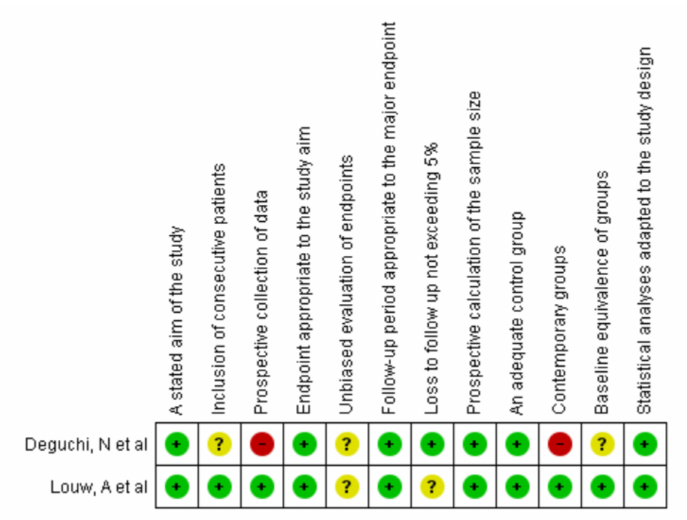
Figure 2. Risk of bias with the Minors scale. Source: Own source with Revman Manager